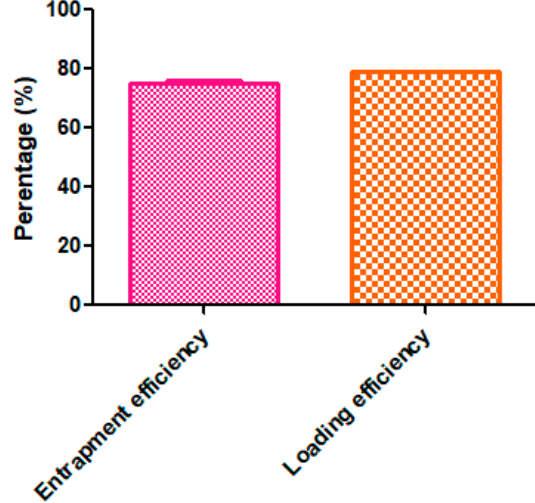
Figure 6. Photothermal response and photothermal stability of T GNC-DOX. ( A ) Increased temper- ature of different groups after 808 nm NIR laser exposure for 15 min at 2.4 W/cm 2 recorded using NIR camera. ( B ) Photothermal stability of developed T GNC-DOX after 808 nm NIR laser irradiation is repeated.